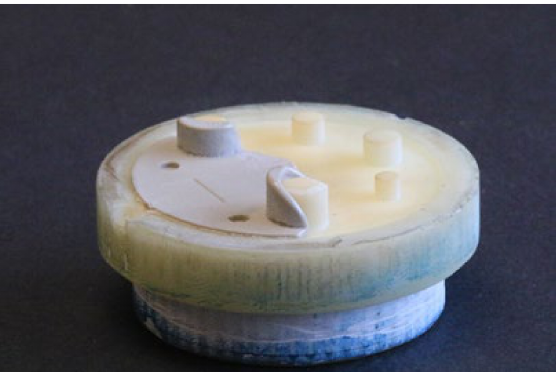
Figure 11. Frozen flow front from an incompletely moulded part; an incomplete part is assembled on the 3DIM to show the flow progression path.